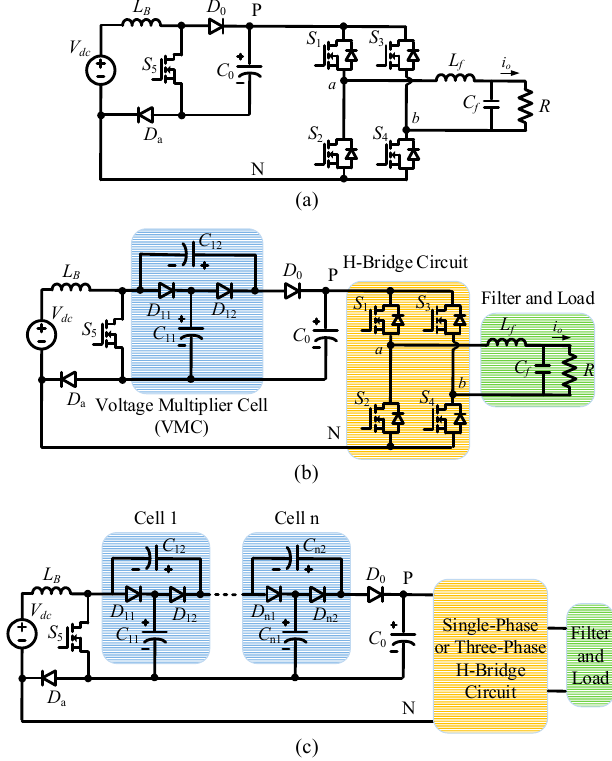
Figure 1. Conventional and proposed inverter topologies. ( a ) Conventional quasi-switched boost inverter (qSBI), ( b ) proposed single voltage multiplier cell (VMC-qSBI), and ( c ) proposed n -VMC-qSBI extension topologies.